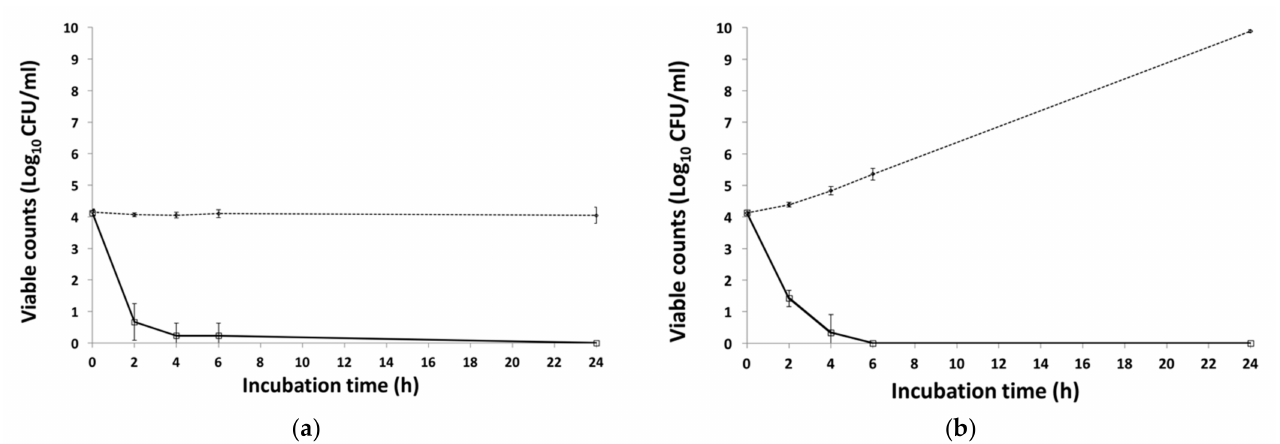
Figure 2. Effect of phage VR26 on numbers of STEC O26:H11 in LB medium at 4 ( a ) and 22 ◦ C ( b ). Solid line, VR26-treated cultures; dashed line, control. Bars present standard